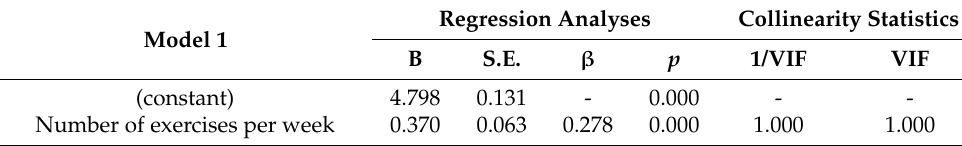
Table 7. Regression analyses and significance test ( N =